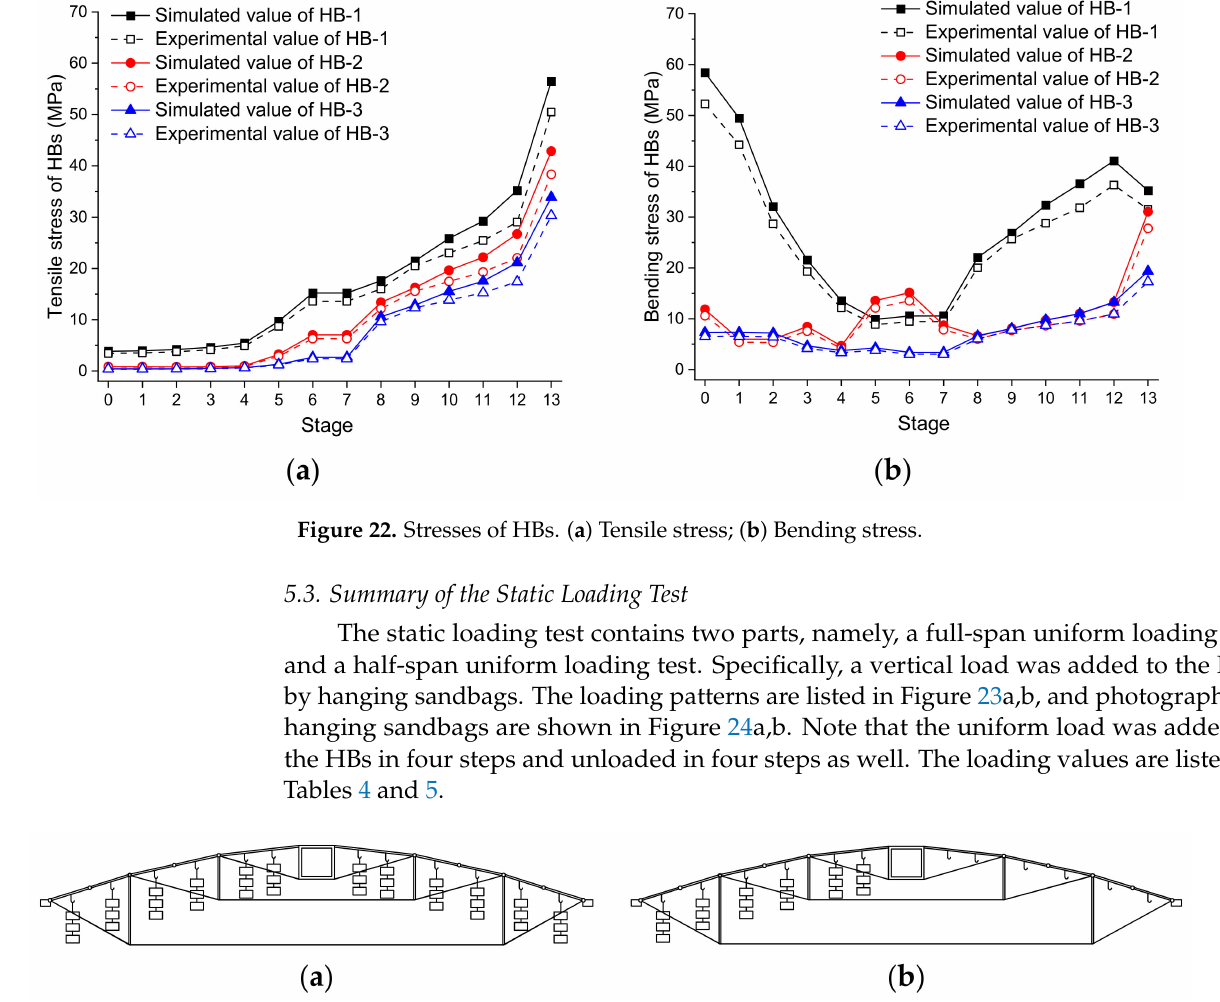
Figure 23. Elevation graphs of the static loading test. ( a ) Full-span; ( b )